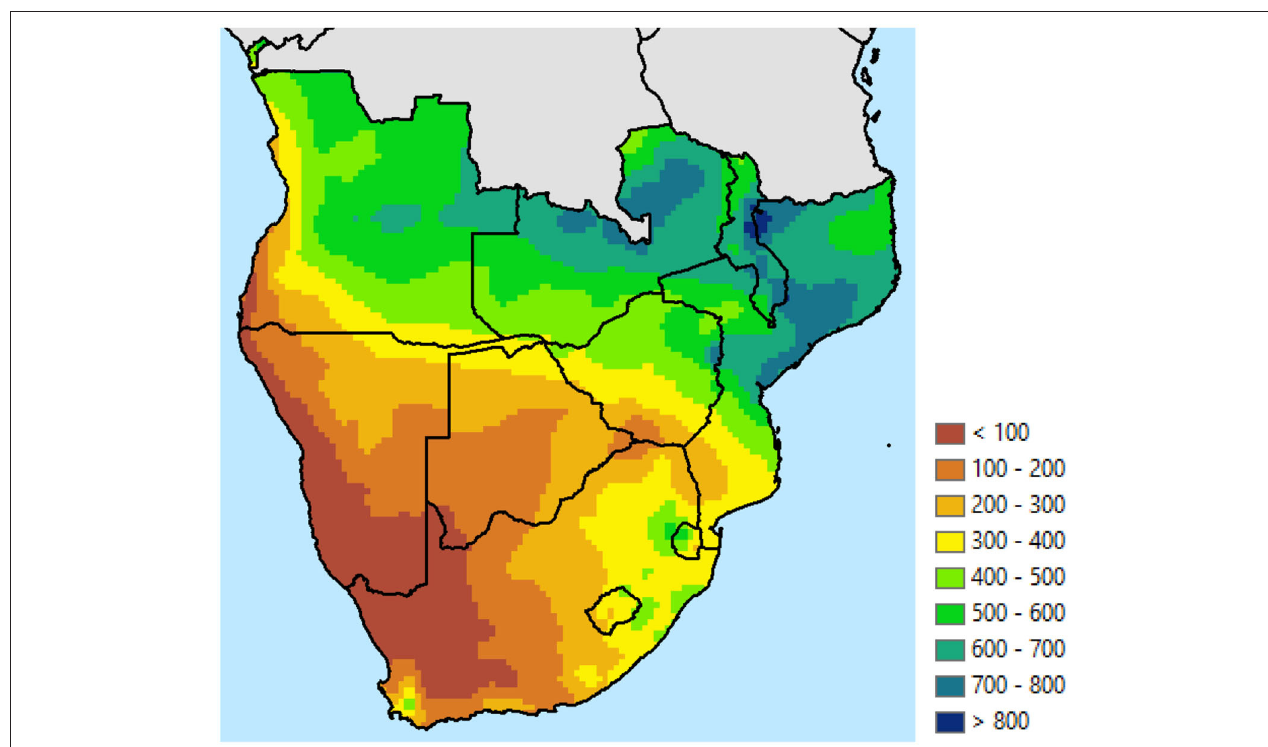
FIGURE 3 | Rainfall in wettest 3 months, millimeters, 1981–2000. Source: Authors’ calculations based on Princeton Global Forcings, version 3 [2018, based on Sheffield et al.